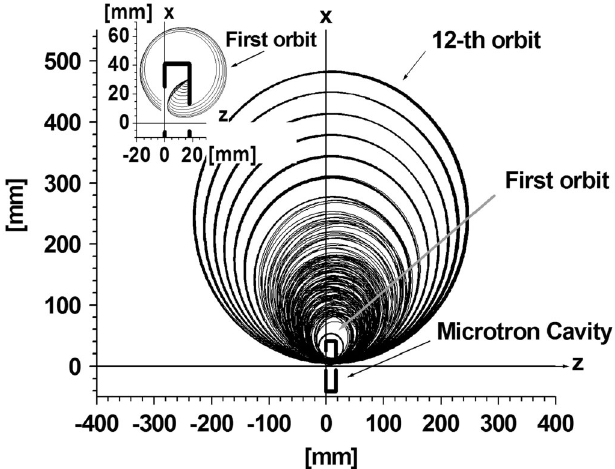
FIG. 1. 2D tracking in median plane of the microtron. In the left corner is shown the tracking of the first orbit and the layout of the accelerating cavity having narrow radial slits for passage of the